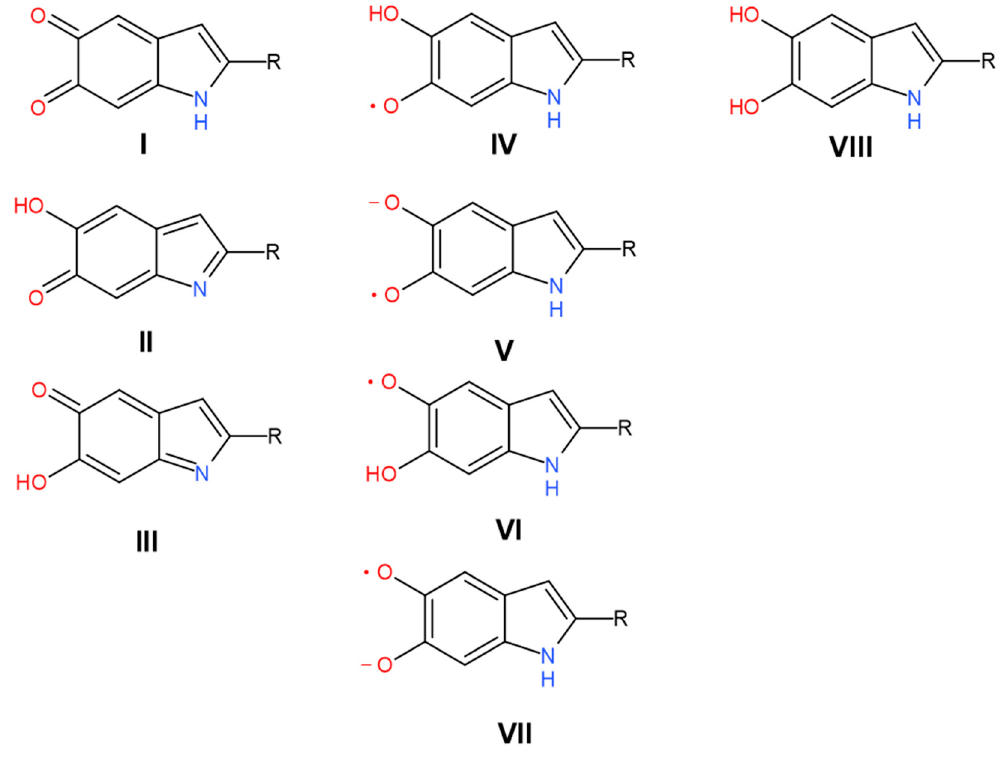
Figure 1. Redox states and tautomeric forms of monomers within the eumelanin chain. R is H (for DHI) and COOH (for DHICA). The left column includes fully oxidized forms: I —quinone, II —quinone methide, III —quinone imine. The central column contains semi-reduced radical forms: IV , VI —protonated semiquinones, V , VII —deprotonated radicals. The right column contains a single fully reduced form: VIII —hydroquinone.